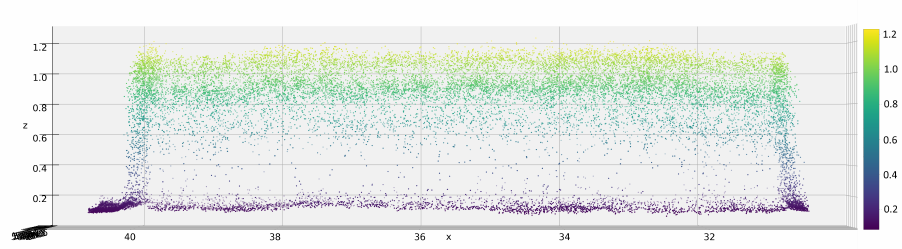
Figure 9. Side view on individual field-plot detected by the